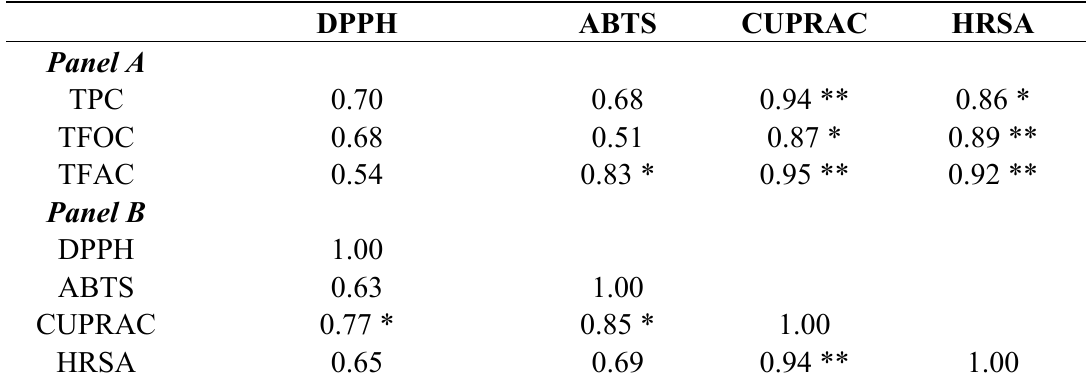
Table 4. Linear correlation coefficients between phenolic composition and antioxidant capacity (panel A), and among the different methods for quantifying antioxidant capacity (panel